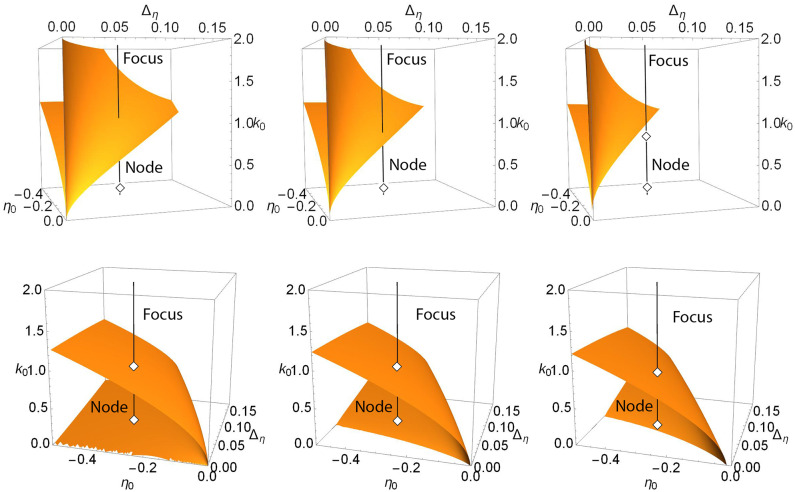
Case 1: Plots of the saddle-node surface (top) and the node-focus surface (bottom) for Δk = 0.0 (left), 0.1 (middle), and 0.2 (right), with n = 2. The black lines correspond to η0 = −0.3 and Δη = 0.08, and show the path traversed along k0 in the bifurcation diagrams shown in Figure 1. Equilibria along the lines are labeled node or focus; see the discussion in the text. In the upper sequence, a hidden node-focus transition (open diamond) emerges in the right panel.